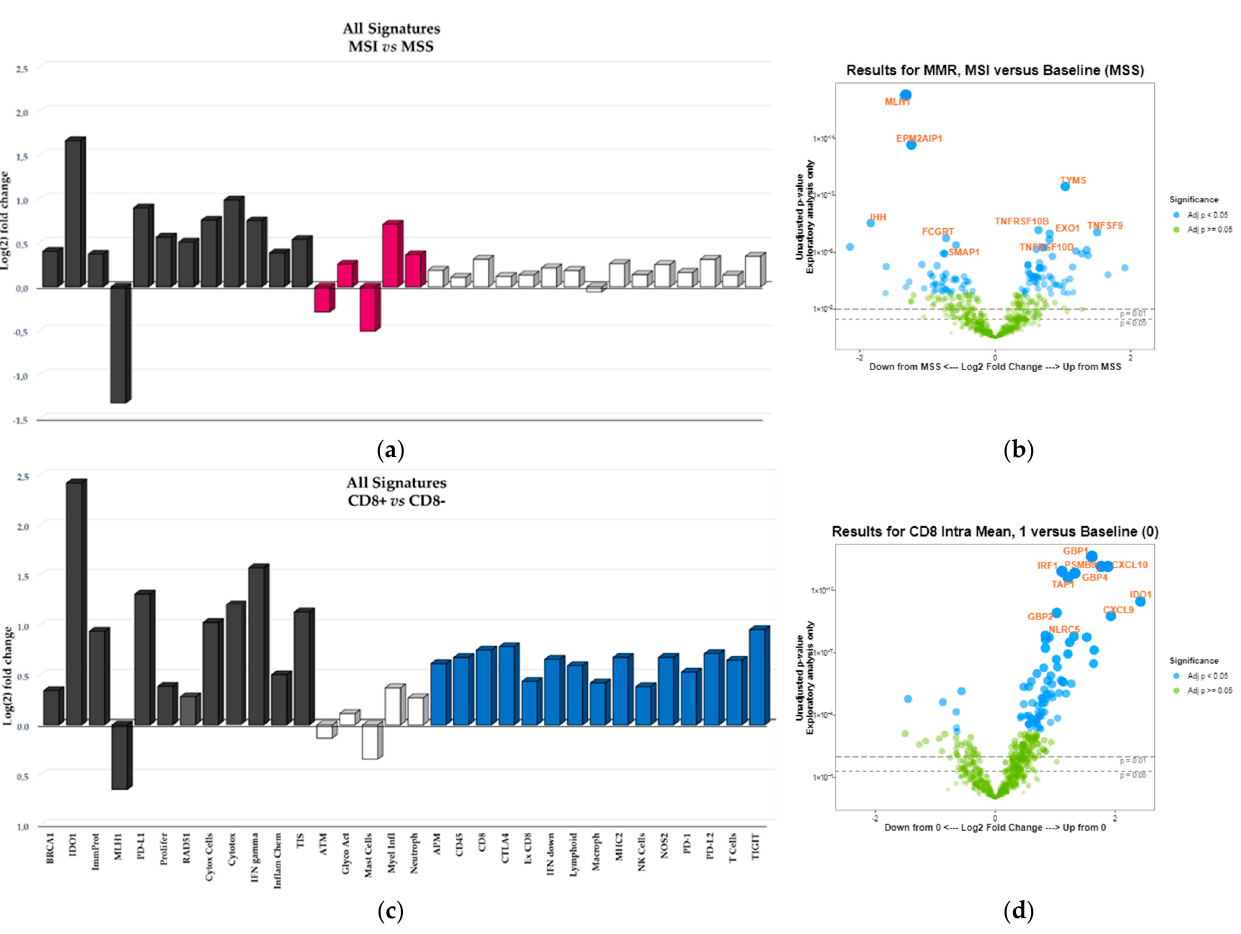
Figure 2. ‘All Signatures’ histograms display the 32 signatures that are overexpressed/downregulated in MSI versus MSS samples ( a ) and in CD8+ versus Cd8 − samples ( c ). Differential expression versus the baseline group (MSS or CD8-, respectively) is reported on y-axis as signature’s Log(2) fold change. Black bars indicate those signatures that are significantly overexpressed/downregulated in both MSI and CD8+ groups; burgundy bars represent the signatures overexpressed/downregulated in just MSI group, blue bars indicate the signatures overexpressed/downregulated in just CD8+ group; white bars represent the signatures that are not differential expressed versus the baseline groups ( p > 0.05). Volcano plot displays each gene’s fold change (or difference on the Log(2) scale) and significance ( p -value) between MSI and MSS samples ( b ) and between CD8 positive (CD8+, category 1) and CD8 negative (CD8 − , category 0) samples ( d ), represented along the x-axis, with the significance ( p -value) along the y-axis. Genes that have greater statistical significance will produce points that are both larger and darker in hue, in addition to appearing higher on the plot. Genes that have greater differential expression versus the baseline group (MSS or CD8 − , respectively) appear further from the center of the plot. Genes further to the right indicate an increase in expression, and signatures or genes further to the left indicate a decrease in expression relative to the baseline group. Horizontal lines indicate 0.01 and 0.05 p -values; blue dots indicate adjusted p -values lower than 0.05; green dots indicate adjusted p -values higher than 0.05.